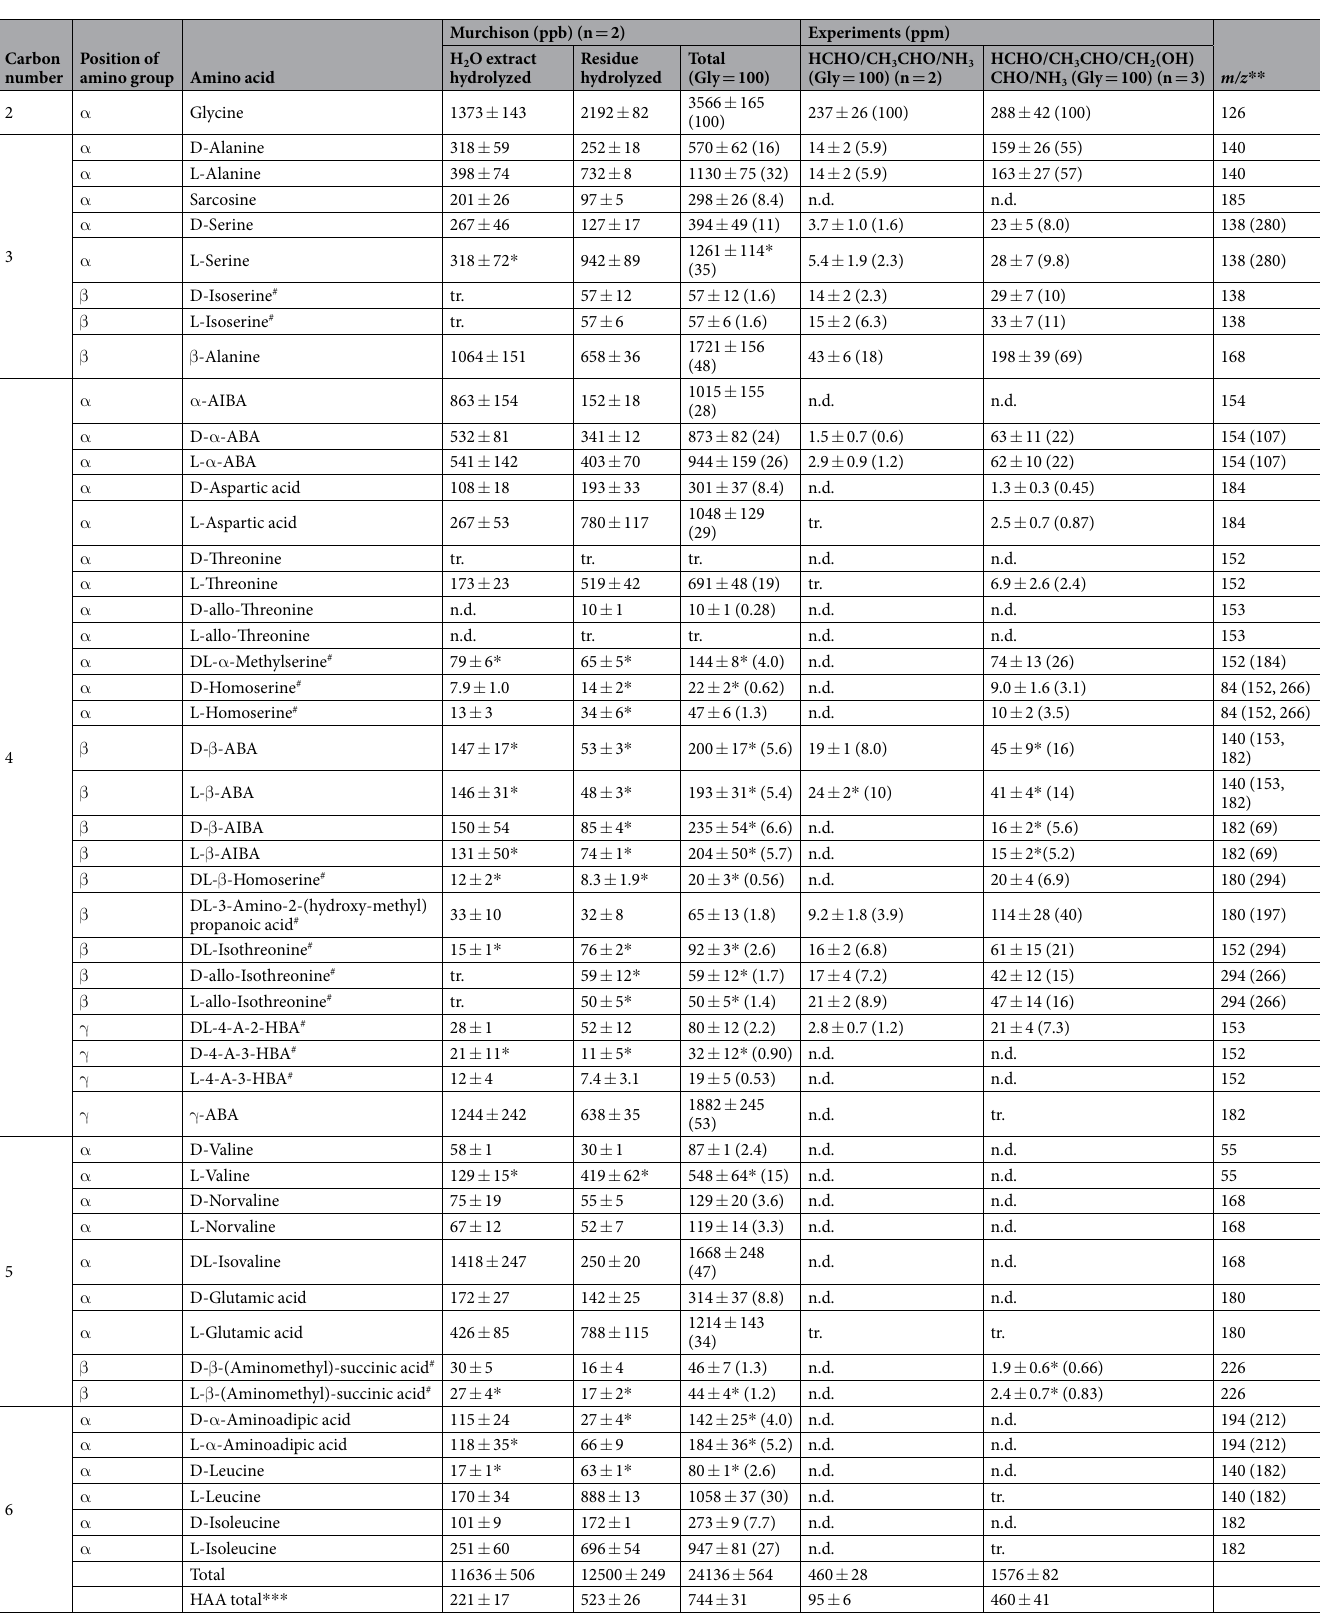
Table 1. Amino acids identified in the Murchison meteorite and the experimental products. n.d.: not detected; tr.: trace amount. # Firstly identified in the Murchison meteorite. * The chromatographic peak overlapped with other peak(s) including its enantiomer. ** The m/z was used for the quantification of amino acids. The m/z in parenthesis was secondarily used. *** The total concentration of newly identified hydroxy amino